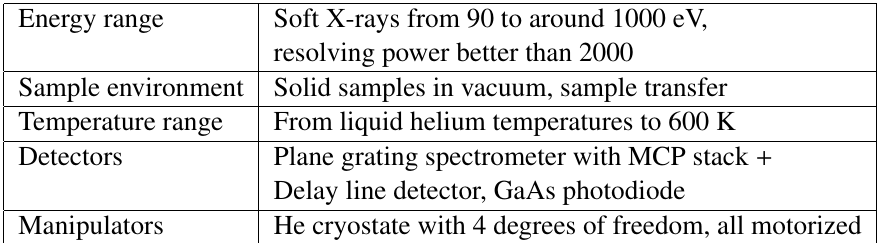
Table 1: Technical parameters of the µ mRIXS